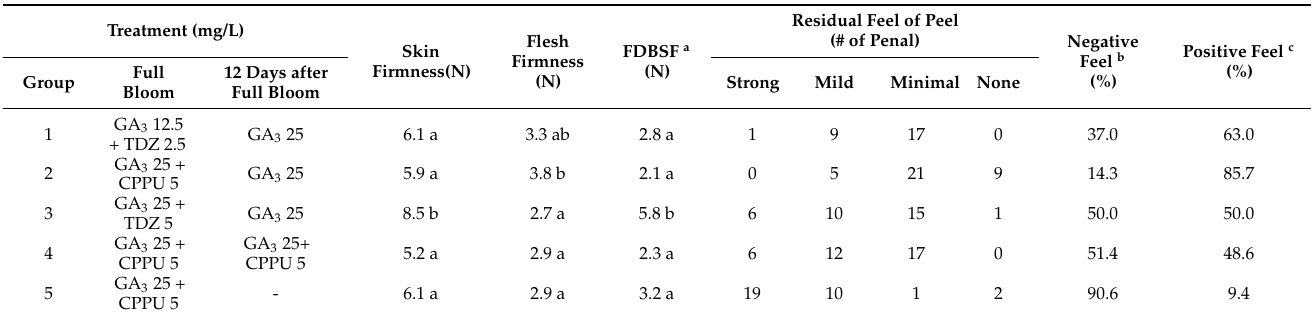
Table 4. Comparison of berry firmness and sensory evaluation of the fruit according to the growth regulator treatment in the ‘Shine Muscat’